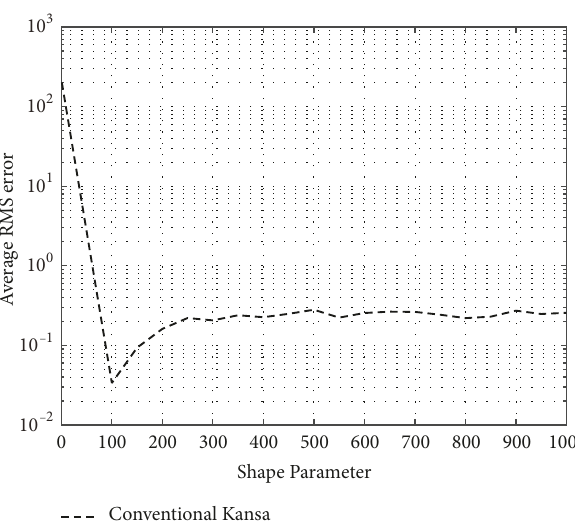
Figure 3: Effect of the Gaussian shape parameter ( 𝜀 ≫ 1.5 ) on the result accuracy for the Hermite collocation scheme computed at Re = 10 with 𝑡 = 0.5,Δ𝑡 = 0.005 , and 𝑁 = 10 × 10 .